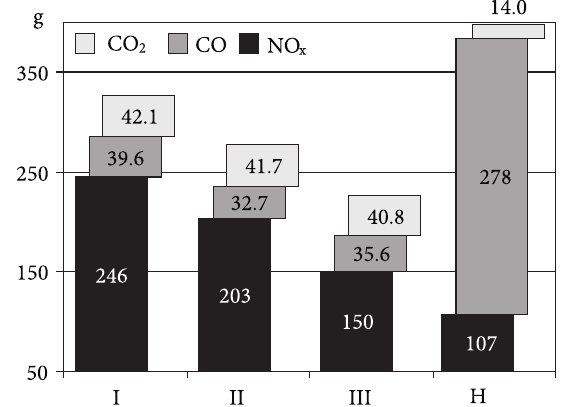
Fig. 9. Distribution of emitted combustion components CO, CO and NO during the test period (3867 s) in the drilling 2 x process by operating modes; I, II, III – tractor’s operation modes, H – mode at